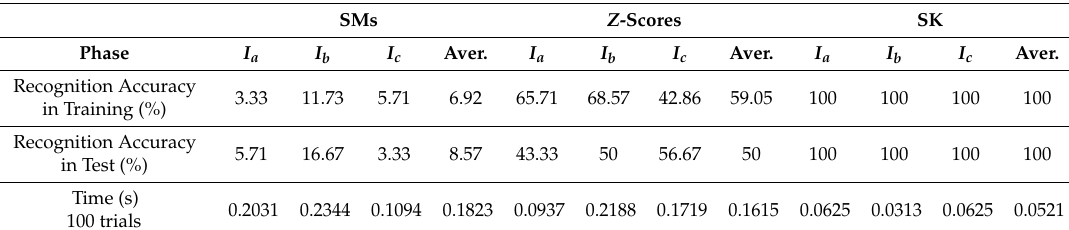
Table 7. Results of SLGF on the bus faults with the k -NN ( k = 1).